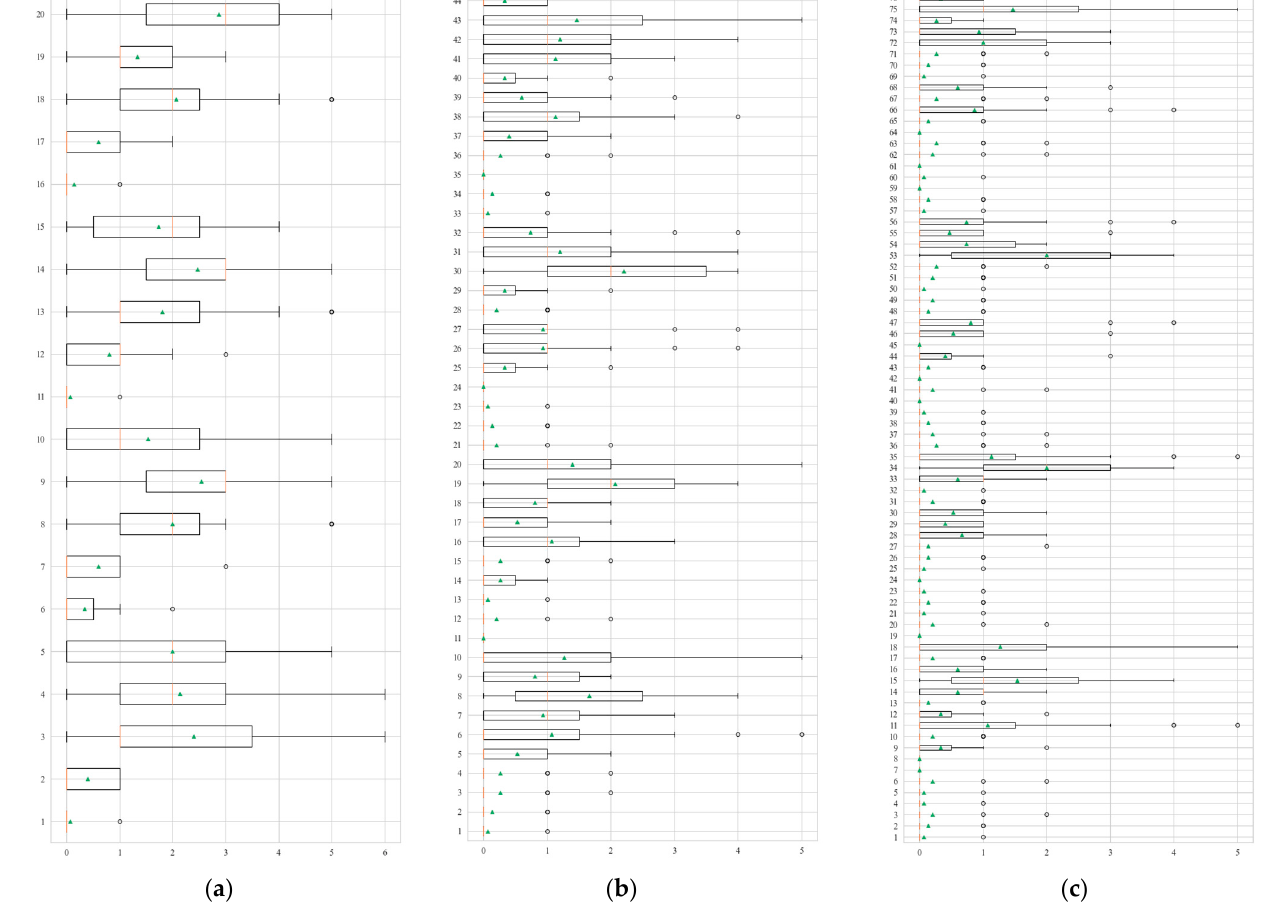
Figure 5. A box and whisker plot: ( a ) purely risky assessment strategy; ( b ) neutral assessment strategy; ( c ) purely conservative assessment strategy.